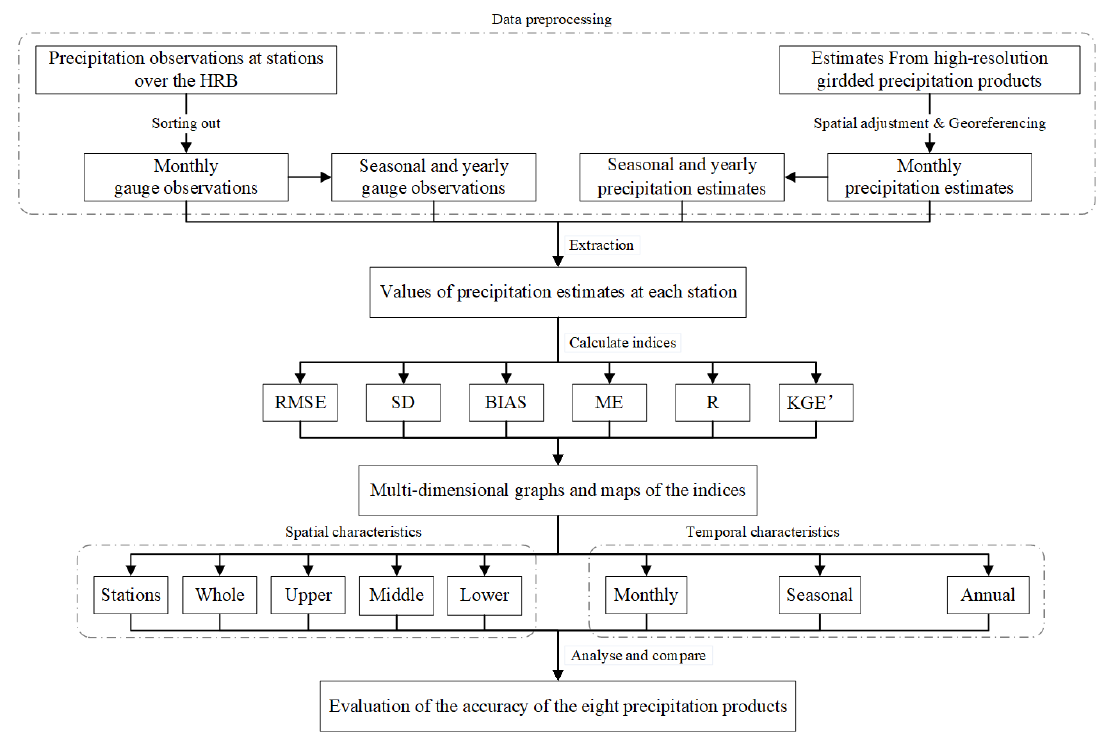
Figure 2. Processing workflow for the precipitation observations at stations and estimates from high-resolution gridded precipitation products of this study.